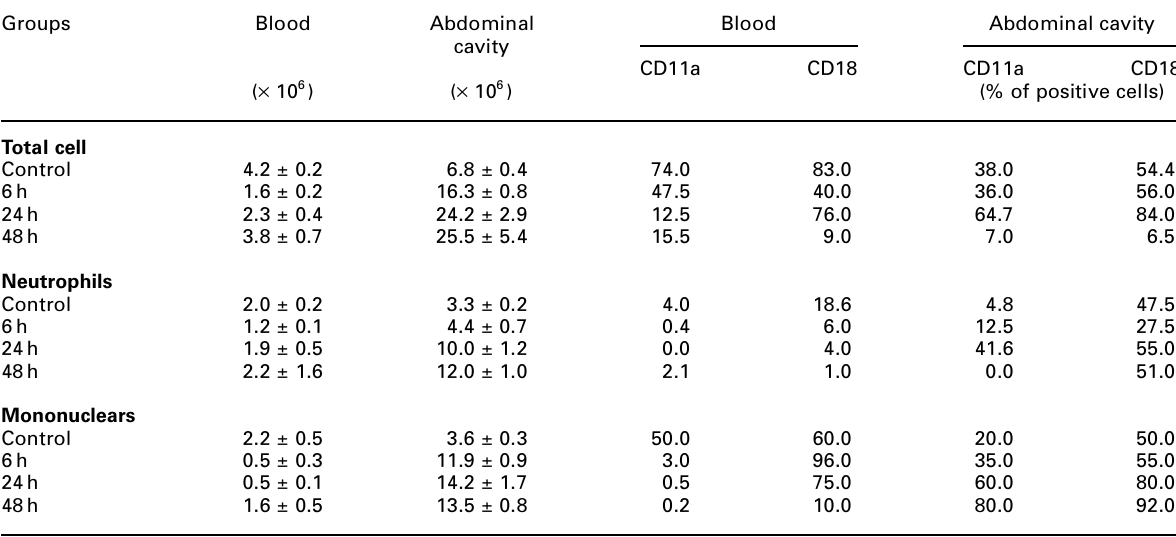
Table 1. Changes in CD11a and CD18 subset cells in the leukocytes harvested from blood and from the abdominal cavity in the studied groups Groups Blood Abdominal